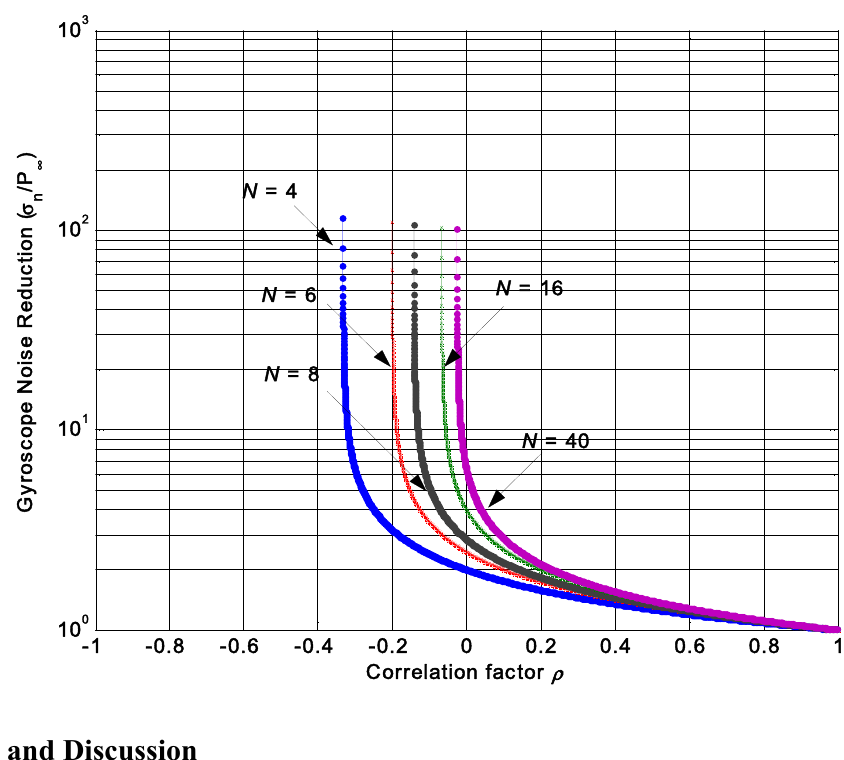
Figure 3. Relationship between the gyroscope noise reduction and correlation factor ρ and sensors number